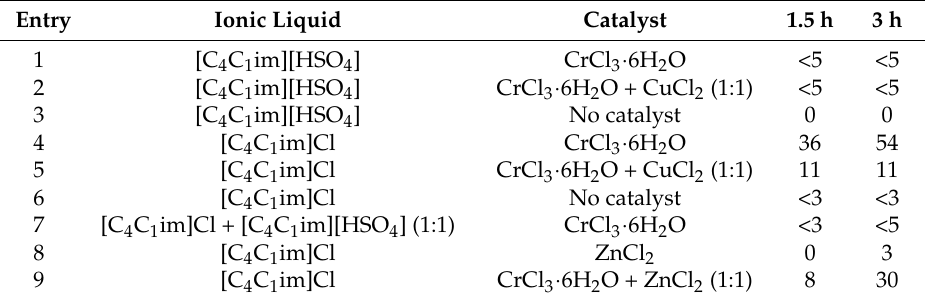
Table 1. Conversion of cellulose to HMF (% yield) in ionic liquids at 120 °C.